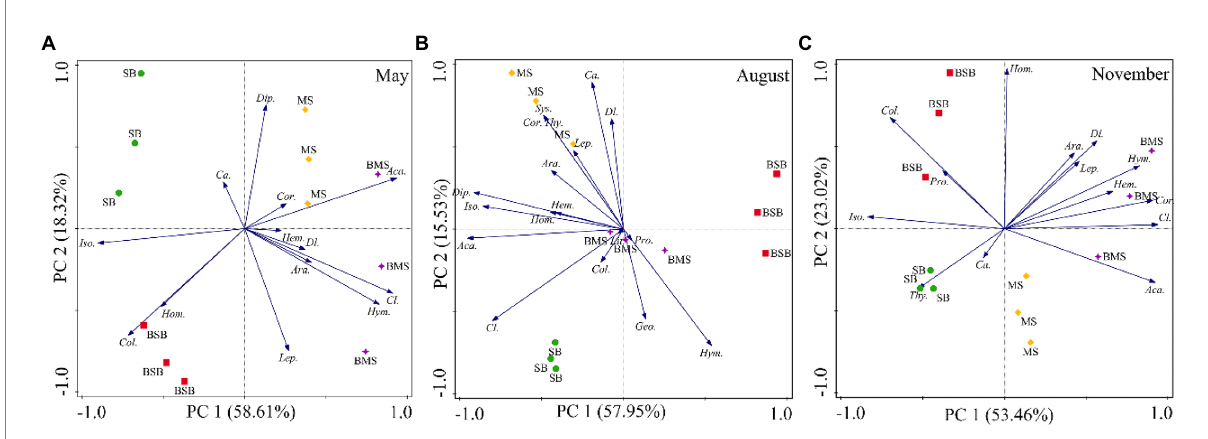
FIGURE 4 Principal component analysis of soil arthropods during May (A) , August (B) , and November (C) with the habitats as an overlay. Ara., Araneae; Aca., Acari; Geo., Geophilomorpha; Lit., Lithobiomorpha; Sys., Sysmphyla; Pro., Protura; Col., Collembola; Dip., Diplura; Iso., Isoptera; Hem., Hemiptera; Cor., Corrodentia; Thy., Thysanoptera; Cl., Coleoptera larvae; Ca., Coleoptera adult; Lep., Lepidoptera larvae; Dl., Diptera larvae; Hym., Hymenoptera; Hom., Homoptera; SB, Stipa bungeana habitat; BSB, Burned Stipa bungeana habitat; MS, Medicago sativa habitat; BMS, Burned Medicago sativa